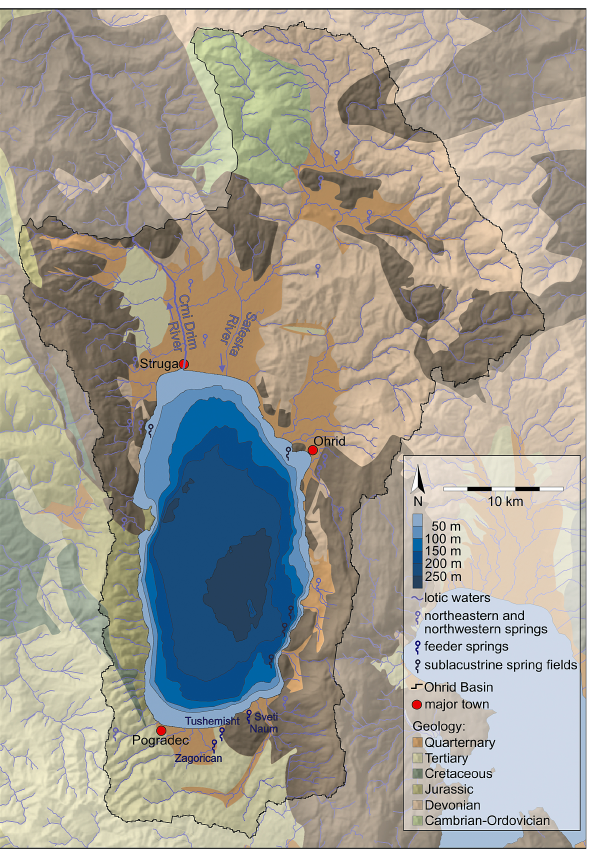
Fig. 1. Map of the Ohrid Basin showing major hydrological and geological features. Map adapted from Hoffman et al.